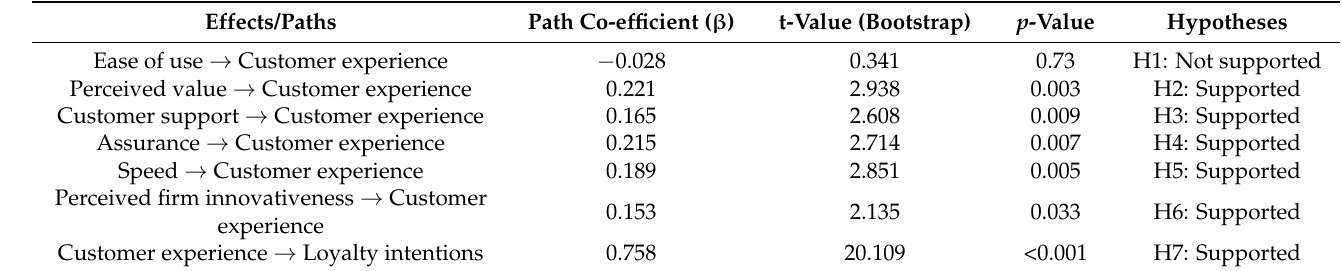
Table 5. The structural model